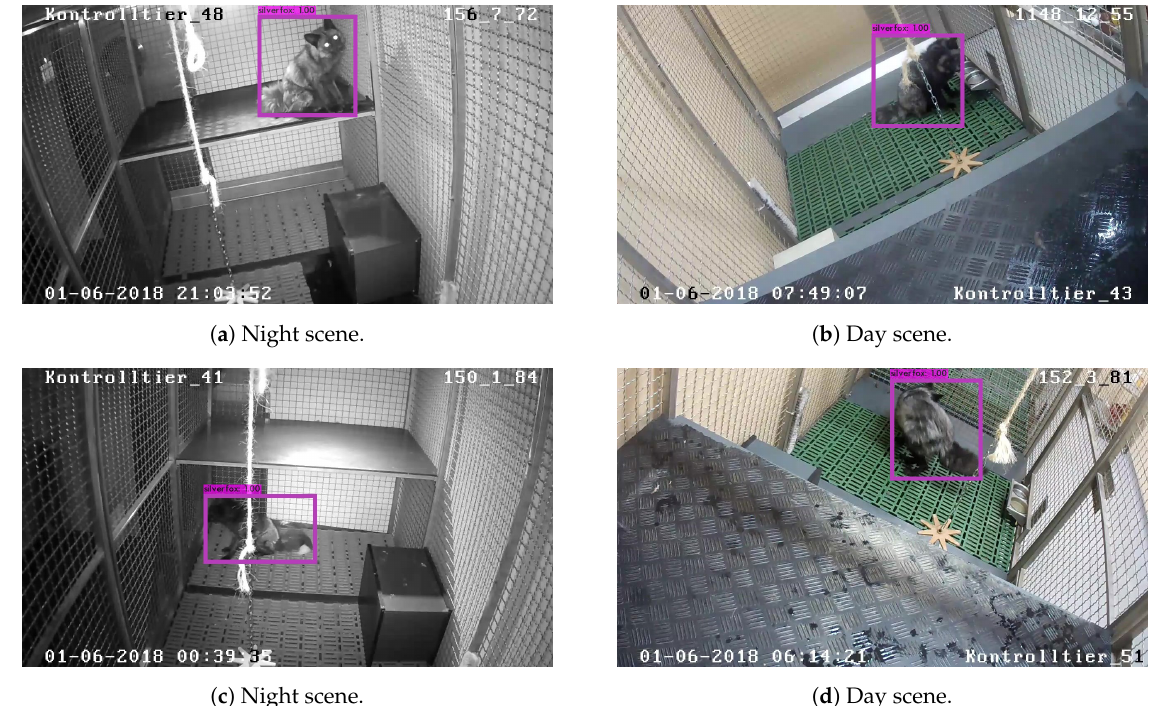
Figure 5. Detection of foxes in single